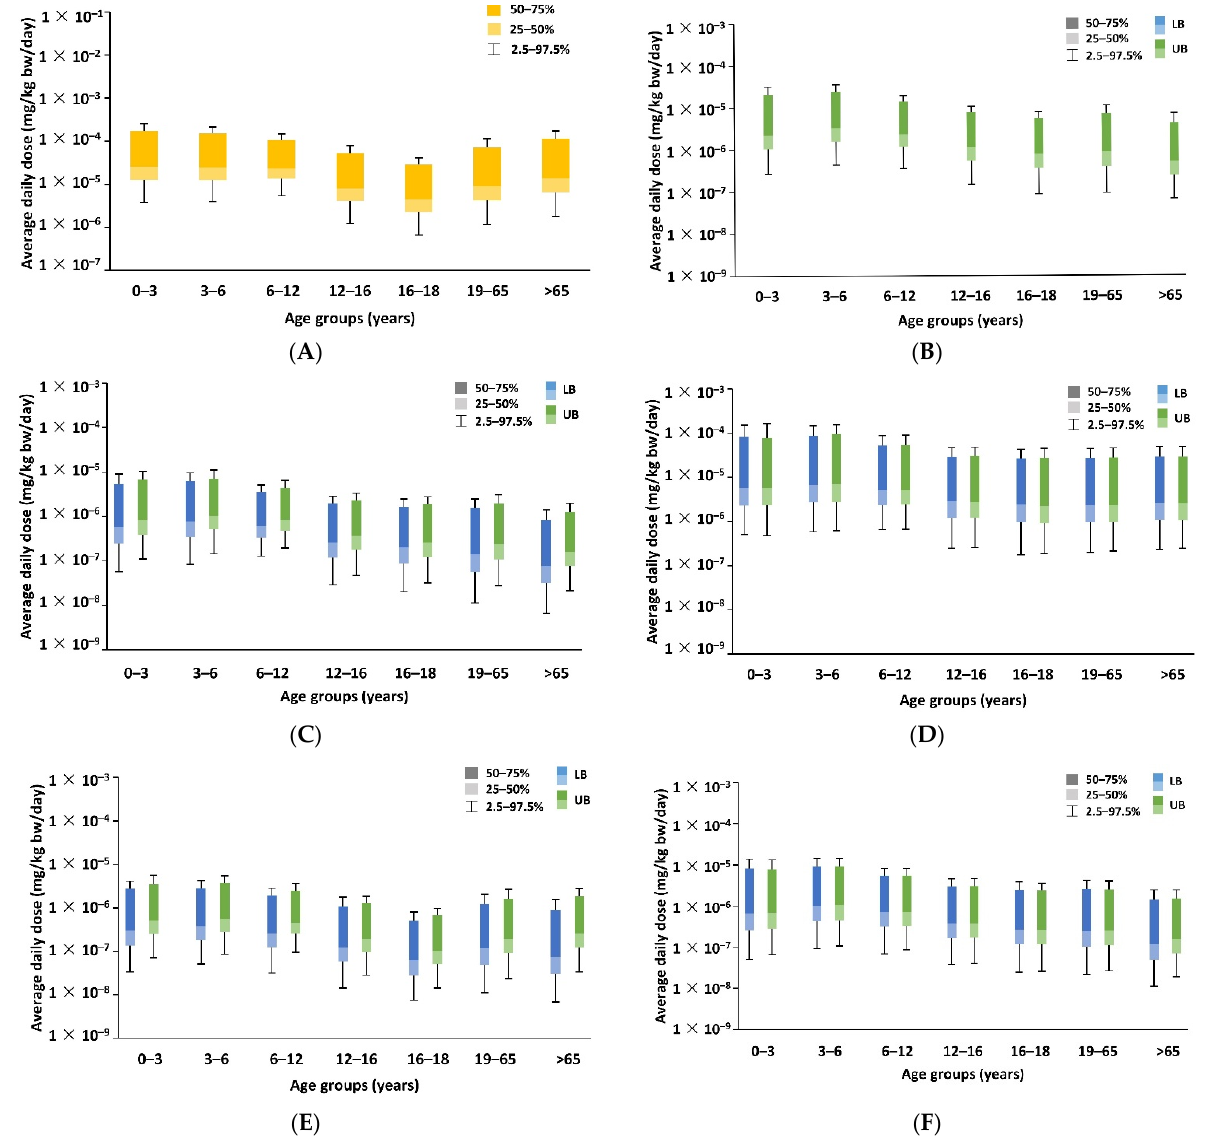
Figure 2. ADD of exposure to BP-type photoinitiators in different age groups (scenario 2). ( A ) BP, ( B ) 2-OHBP, ( C ) 4-OHBP, ( D ) 4-MBP, ( E ) M2BB, ( F ) BPZ. LB = lower bound; UB = upper bound.